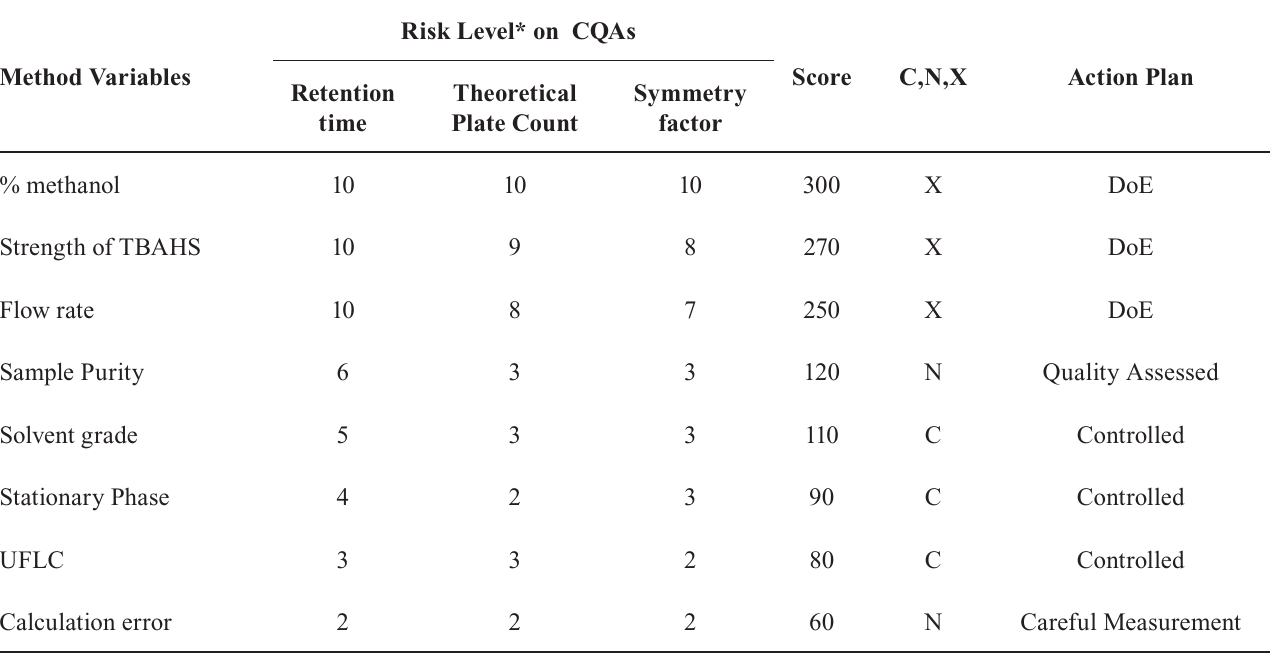
TABLE II - Typical control-noise-experimental (C-N-X) based identification of CMVs